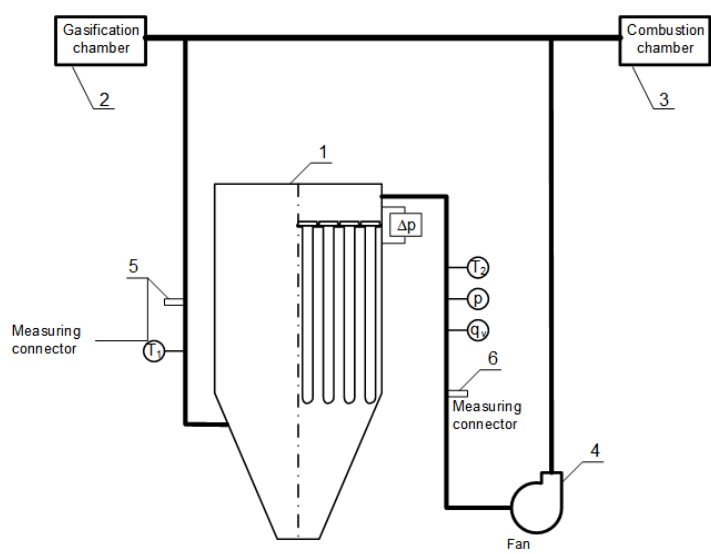
Figure 2. Scheme of the test installation.